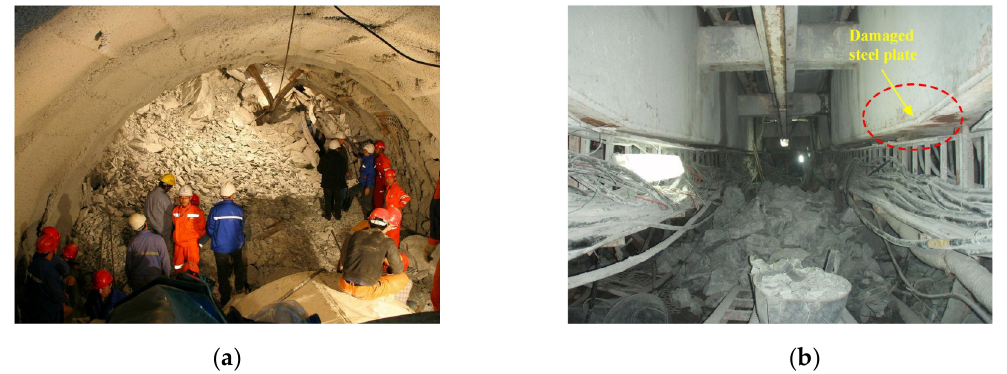
Figure 13. Rockburst in drainage tunnel: ( a ) TBM is buried; ( b ) 80 mm steel plate is damaged.